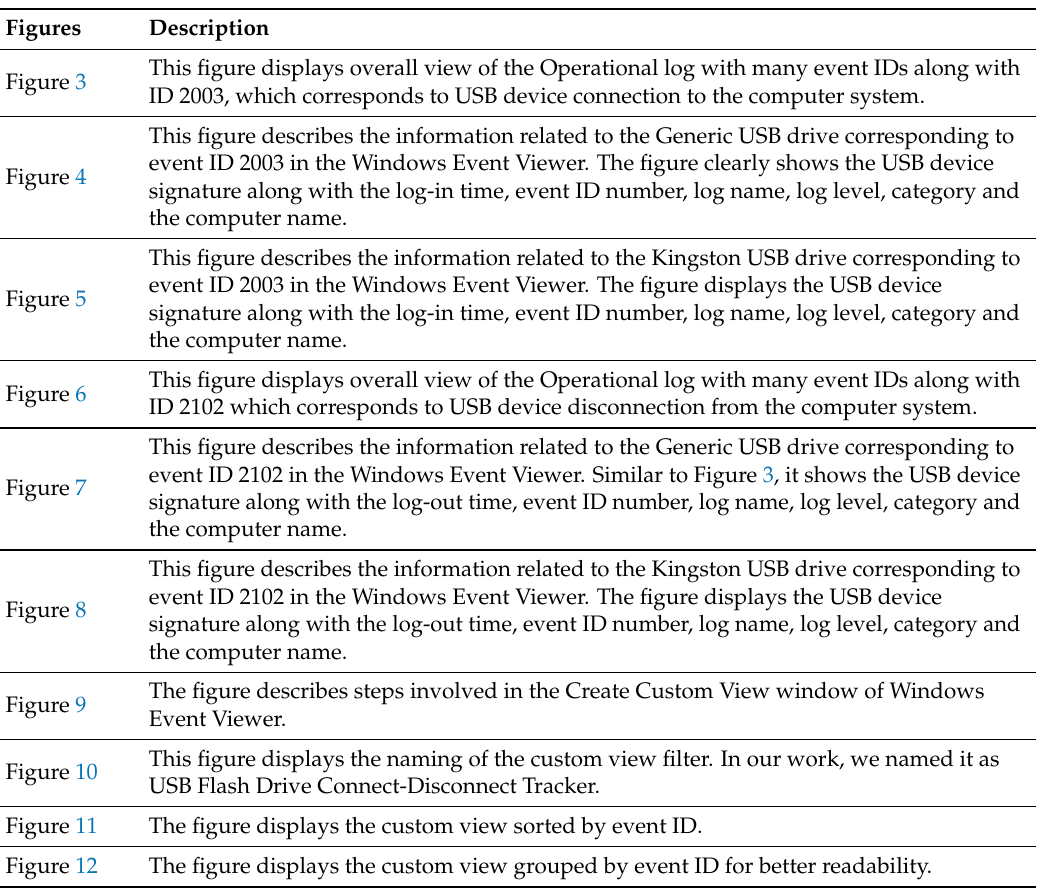
Table 1. The description of figures for Methodology Part 1.